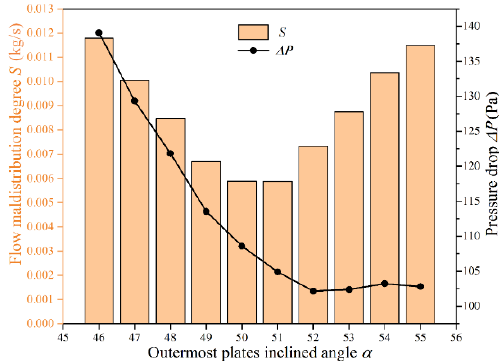
Figure 12. Flow maldistribution degree and pressure drop under different inclined angle of the outermost splitter plates.